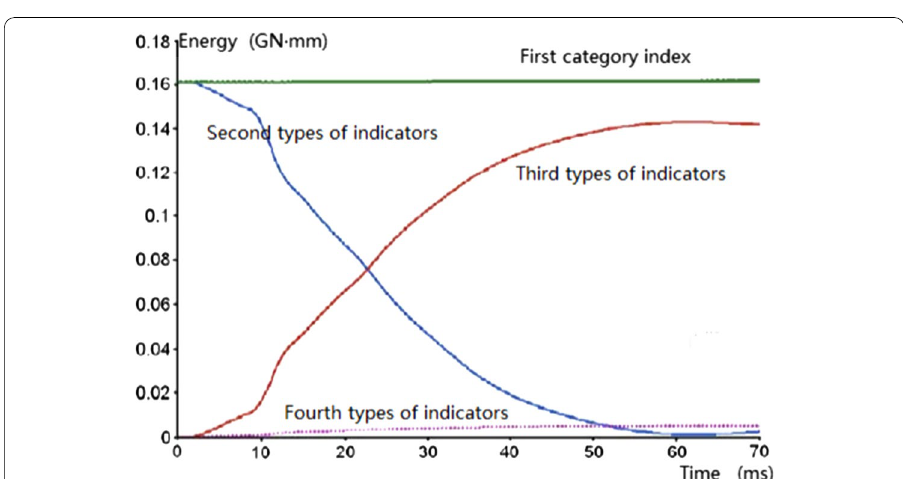
Fig. 3 Constraints among modeling index of solid